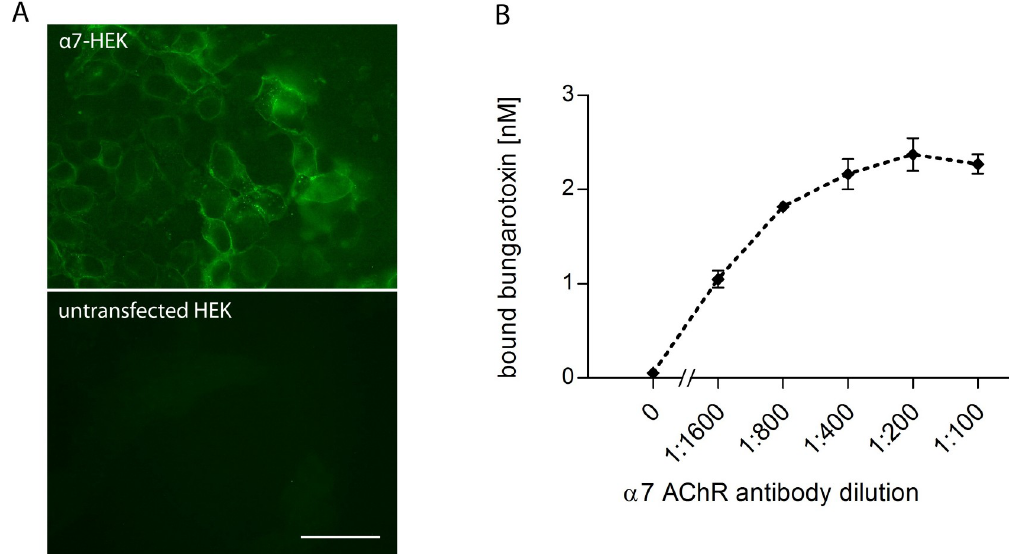
Fig 1. Analysis of a7 AChR expression in HEK293 cells and antibody binding to a7 AChR in cell membrane extracts. (A) α -bungarotoxin-Alexa488 staining of α 7 acetylcholine receptor (AChR) stable transfected, fixed HEK293 cells (top panel) and untransfected, fixed HEK293 cells (lower panel). The scale bar is 50 μ m. (B) Standard curve with α 7 AChR antibody (AB319) in a RIA. The RIA was performed with 125 I α -bungarotoxin and membrane extracts of α 7 AChR transfected HEK293 cells. Data points represent the mean of triplicates and error bars indicate the standard